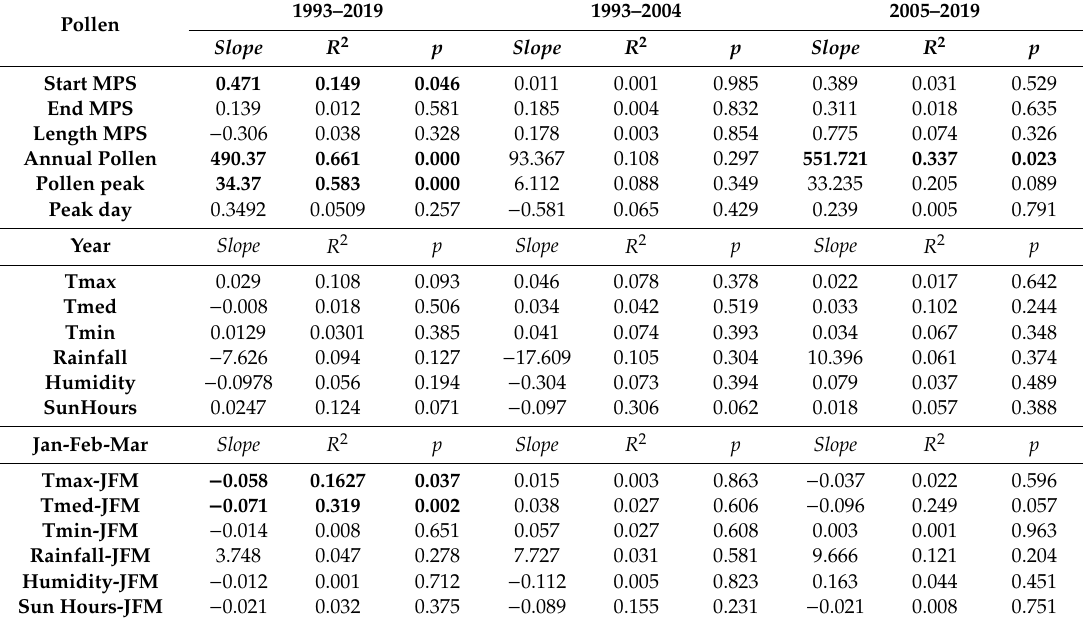
Table 4. Trends of the MPS for pollen (start, end and length dates of the MPS, annual pollen integral, pollen peak concentration and pollen peak day) and for meteorological variables (Maximum, Mean and Minimum temperatures, Total rainfall, Relative Humidity and Sun hours) during the whole data set and during the 1993–2004 and 2005–2019 periods. The shown parameters of the linear regression analysis were slope, R 2 value and p -value (in bold p < 0.01, p <